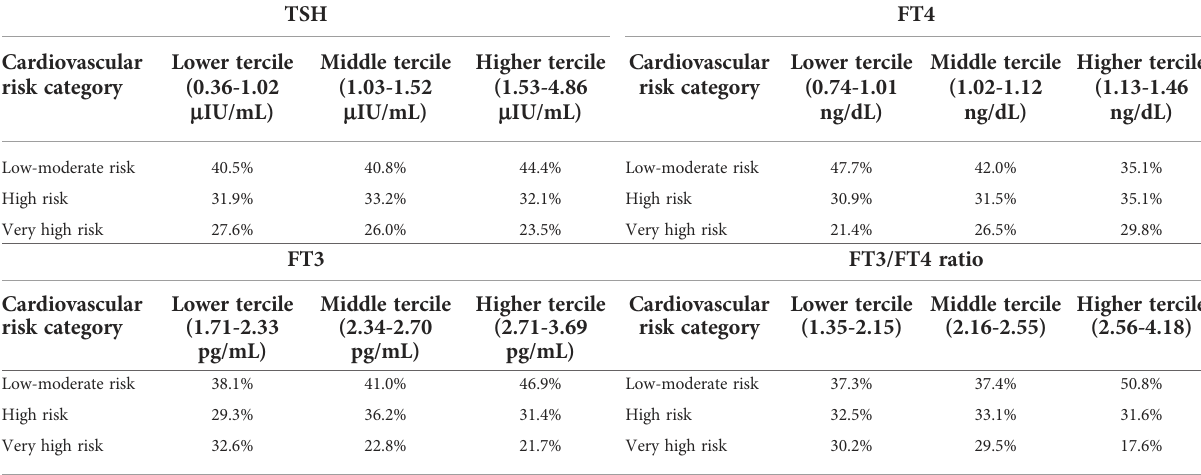
TABLE 6 Association of thyroid function with cardiovascular risk